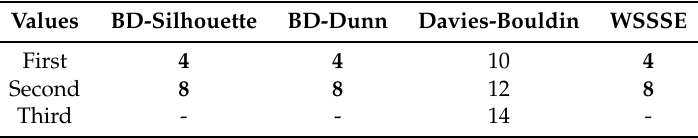
Table 3. Majority voting from cluster validation indices (CVIs).